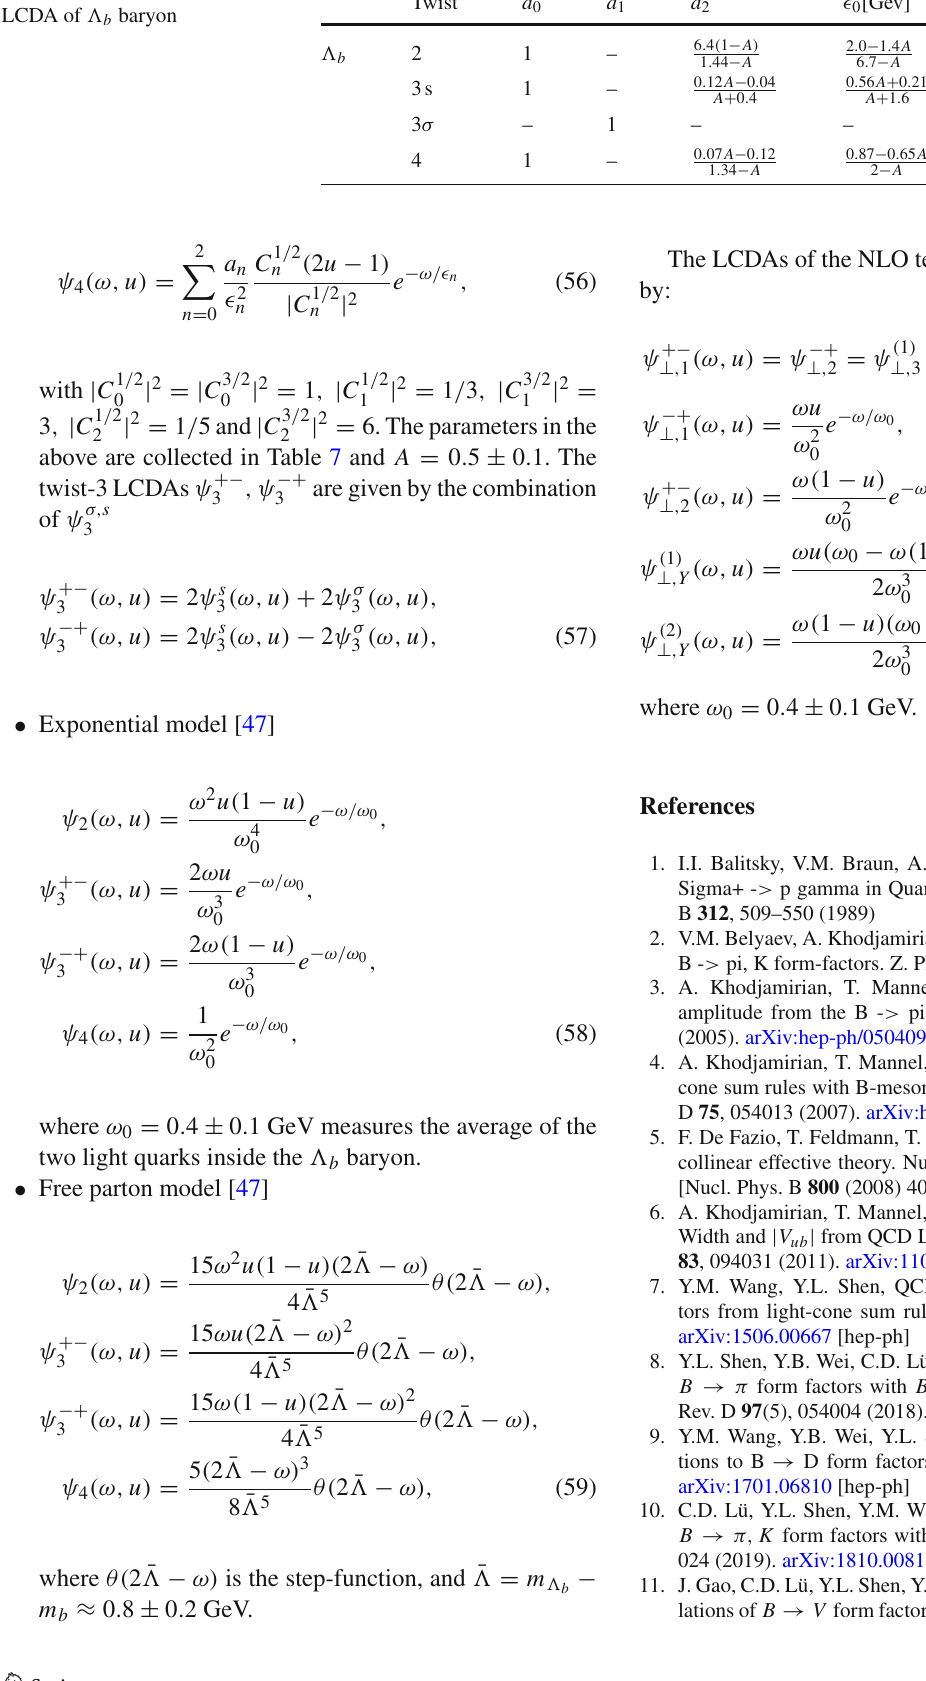
Table 7 Parameters for the LCDA of (cid:2) b baryon